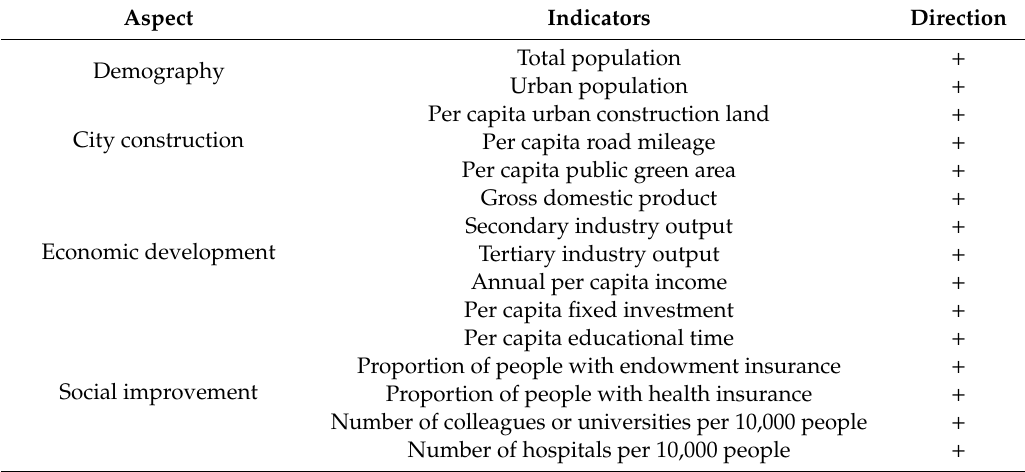
Table 4. Indicators for socioeconomic development